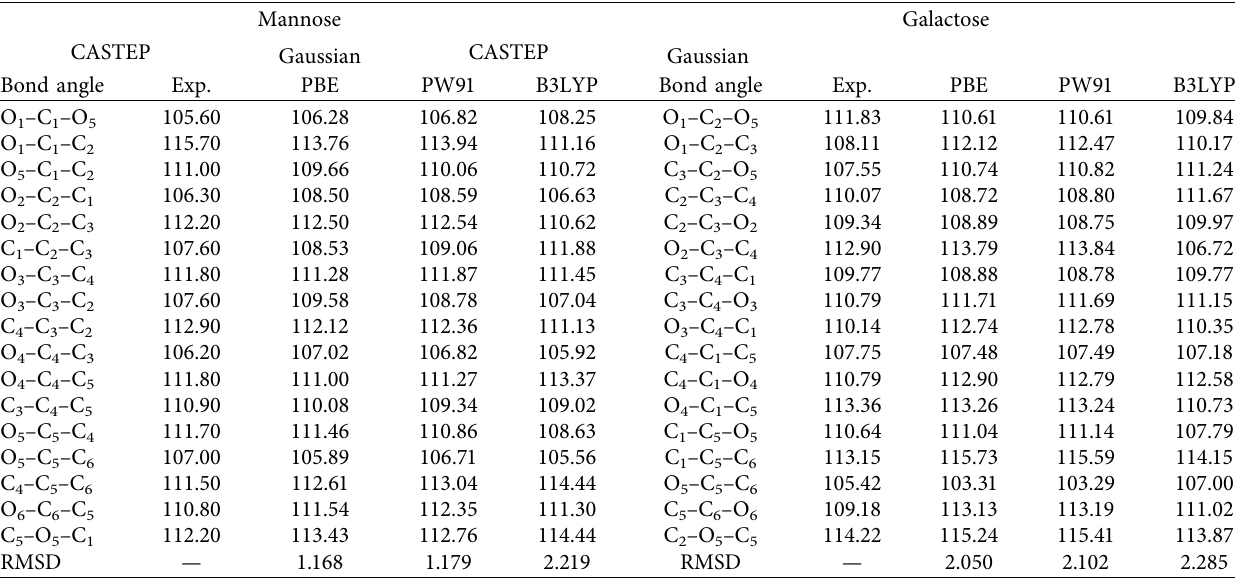
Table 2: Calculated bond angles ( ° ) and RMSD values of mannose and galactose compared to experimental X-ray values a . Mannose Galactose CASTEP Gaussian CASTEP Gaussian